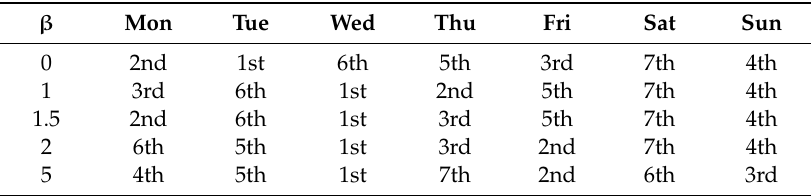
Figure 6. E ffi cient Frontier for case c (million € ). Figure 6. Efficient Frontier for case c (million €). Table 12. Day order scheduling